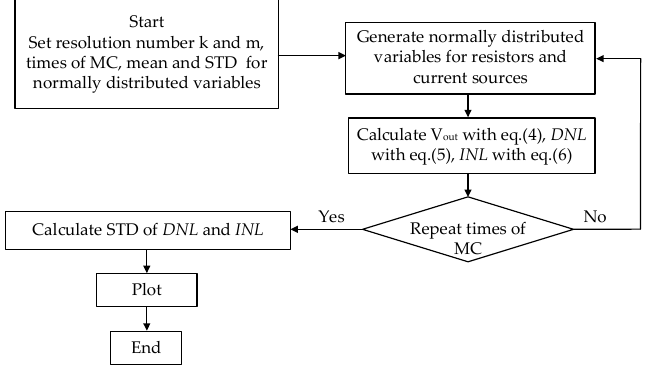
Figure 2. The algorithm of simulation.